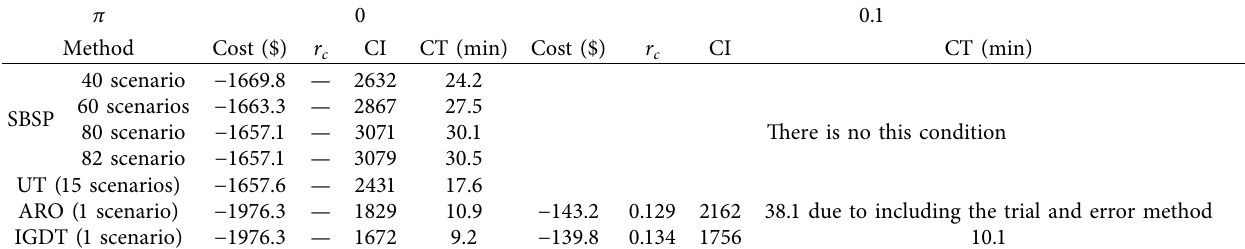
Table 4: Convergence situation based on ALO in the diferent uncertainty modeling method for various values of robustness degree. π